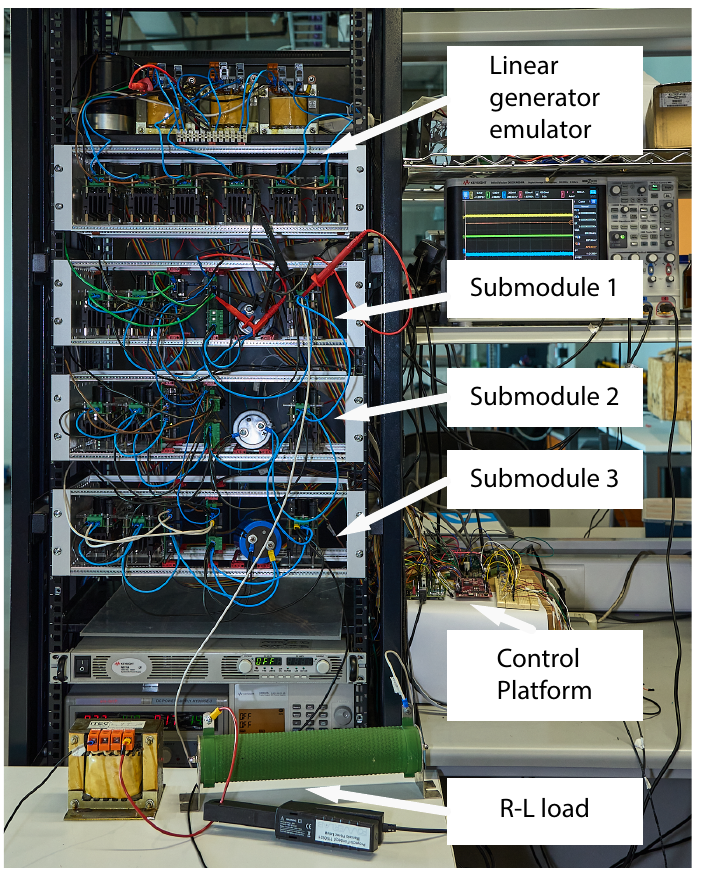
Figure 6. Picture of the experimental